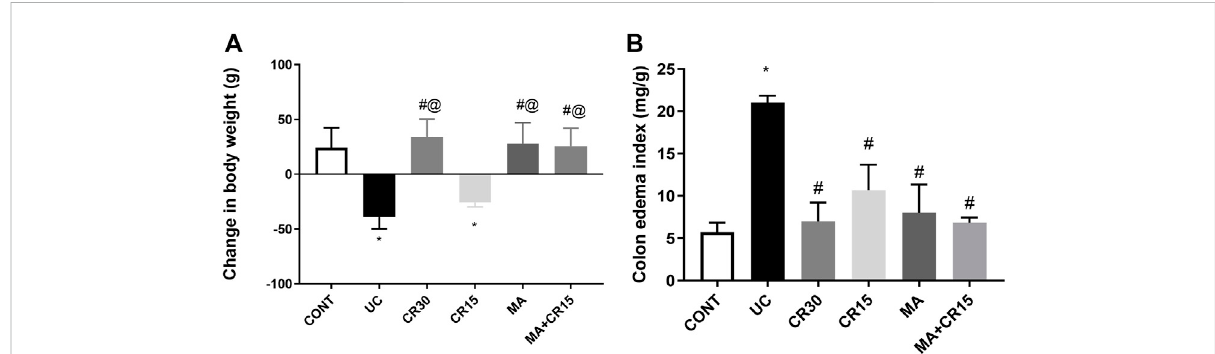
FIGURE 1 Effect of mirabegron and/or carvedilol on (A) body weight, and (B) colon edema index in rats with IAA-induced ulcerative colitis. Data are presented as mean ± SD (n = 6 rats/group). Statistical analysis was carried out using one-way ANOVA followed by Tukey ’ s posthoc test; p < 0.05, as compared to the (*) CONT, (#) UC, and (@) CR15 groups. CONT, control; CR, carvedilol; IAA, iodoacetamide; MA, mirabegron; UC, ulcerative colitis.